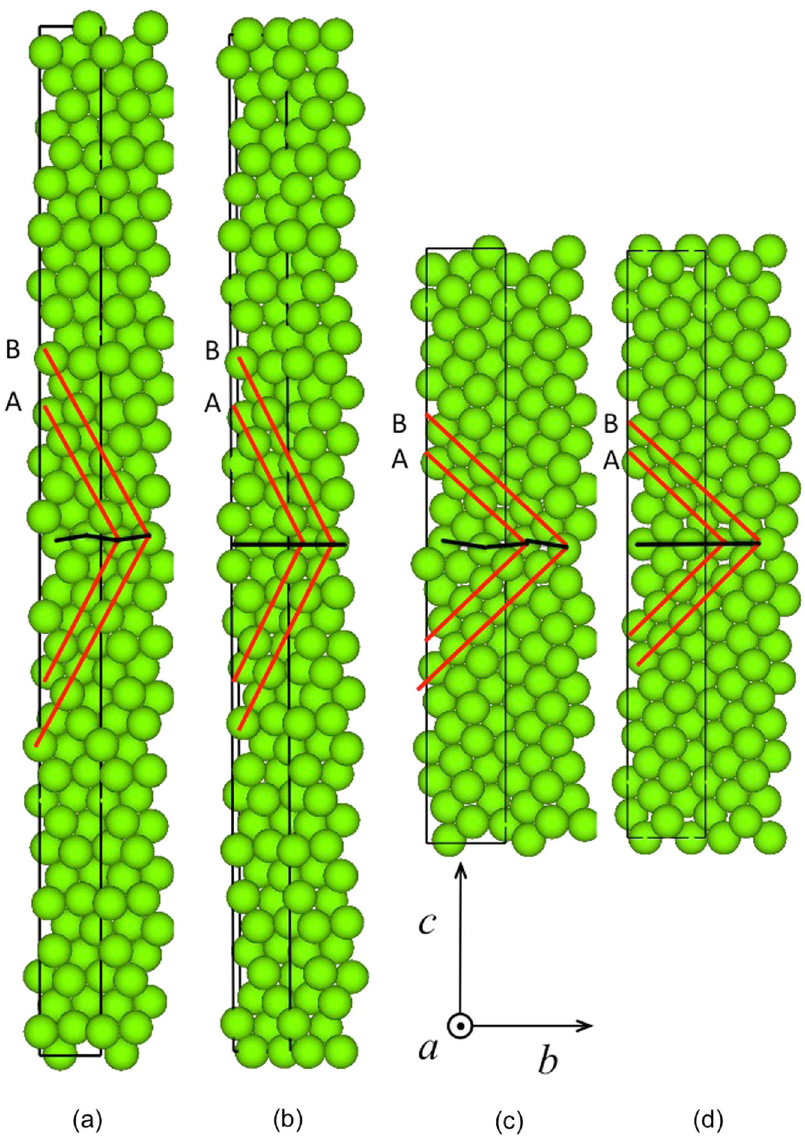
Fig. 1 Supercells of f 1011 g (1 × 1 × 80, 80 atoms) and f 1012 g twins (1 × 1 × 60, 60 atoms) which are indicated by rectangles . Vector a ! is the plane normal of the displacement plane (i.e. 1 = 3 h 1 210 i in both cases), b perpendicular to the twin boundary. a glide twin of f 1011 g , b re fl ection twin of f 1011 g , c Glide twin of f 1012 g , d re fl ection twin of f 1012 g . The black lines indicate the atoms in the centers of the TBs. The basal planes are denoted by red lines . When compressive stress is exerted perpendicular to the basal plane, the compression twins nucleate and grow; when tensile stress is exerted, the tensile twins form. For metals with c / a < 1.633, e.g. Mg, f 1011 g is a compression twinning plane, while f 1012 g a tensile twinning plane. For more details see ref. twinning plane normalized by the atomic plane distance d . These parameters are illustrated in Fig. 2(a) and tabulated in Table 1. By these de fi nitions According to the geometric symmetry, G ( ε , s ) = G ( ε , − s ) = G ( − ε , s ) and G (1 − ε , s ) = G (1+ ε , s ). The relative Gibbs energies Δ G = G ( ε , s ) − G (0,0) for compression and tensile twins in pure Mg are computed and shown in Figs. 2 (c) and (d). The resulting potential energy surfaces show only two local minima. Their existence is independent on the employed potentials albeit with different energetics, as is tested by the potentials of Pei et al . 19 and Sun et al. 21 The two local minima correspond to the glide (TB1) and re fl ection (TB2) TBs, respectively (see Fig. 1). The Gibbs energy surface re fl ects the crystallographic